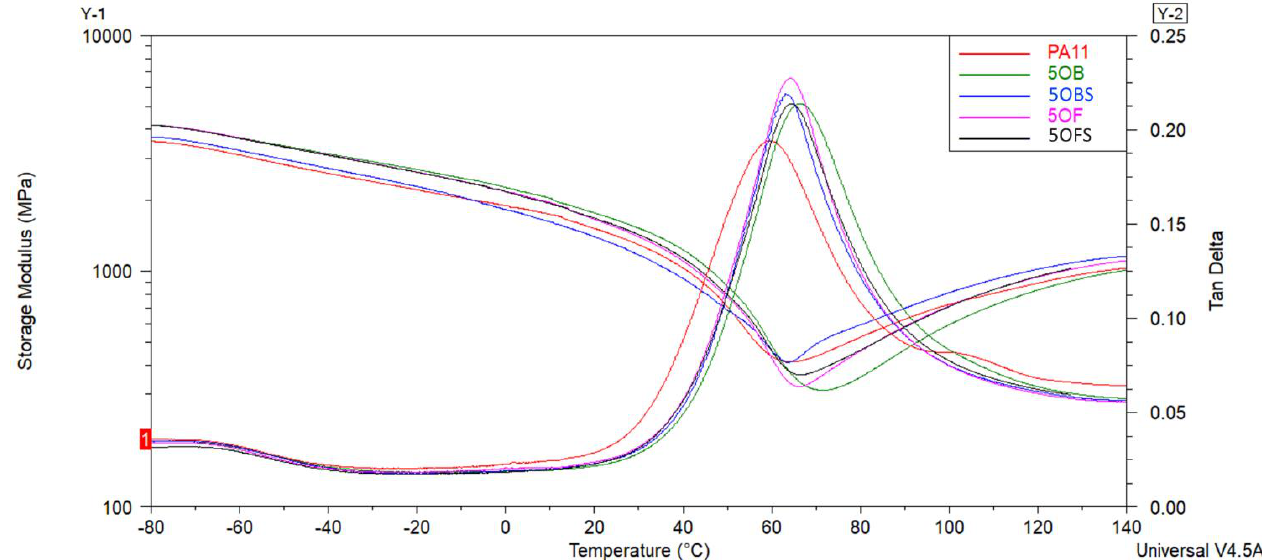
Figure 16. The storage modulus and tan δ curves of unmodified PA11 and composites; samples with 5% of diatoms.